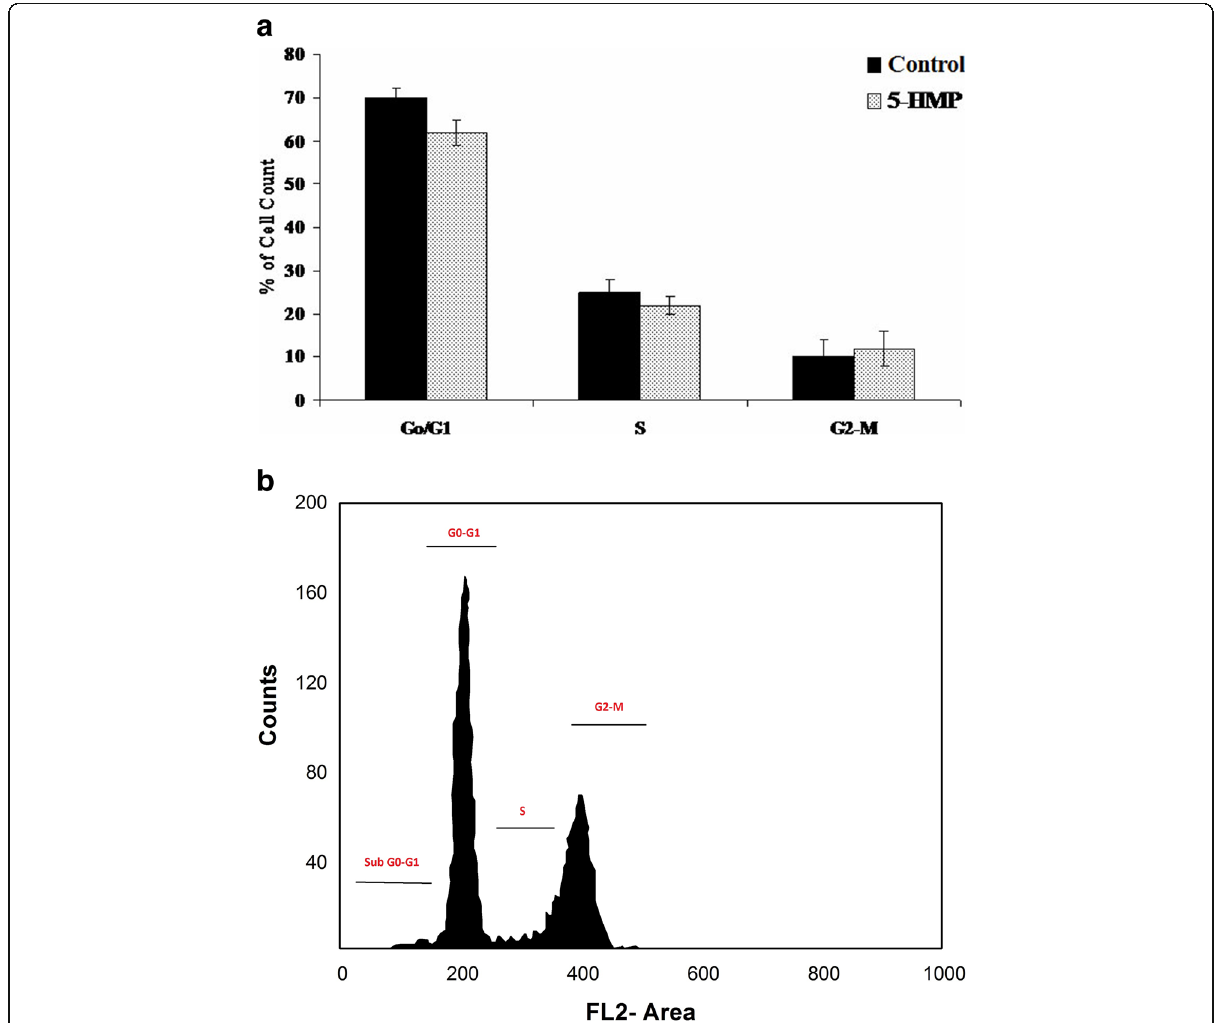
Fig. 4 a Effect of 5-HMP on A549 cell cycle . b Cell cycle distribution of 5-HMP (30 μ g/ml) treated A549